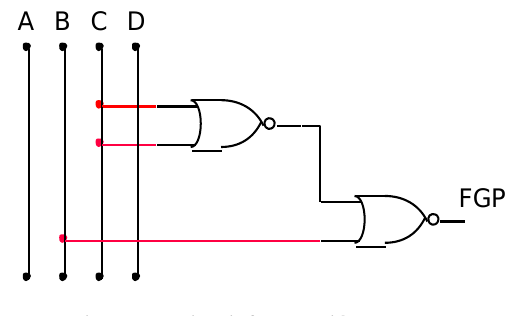
Figure 14. Circuit for F 5 with one error.